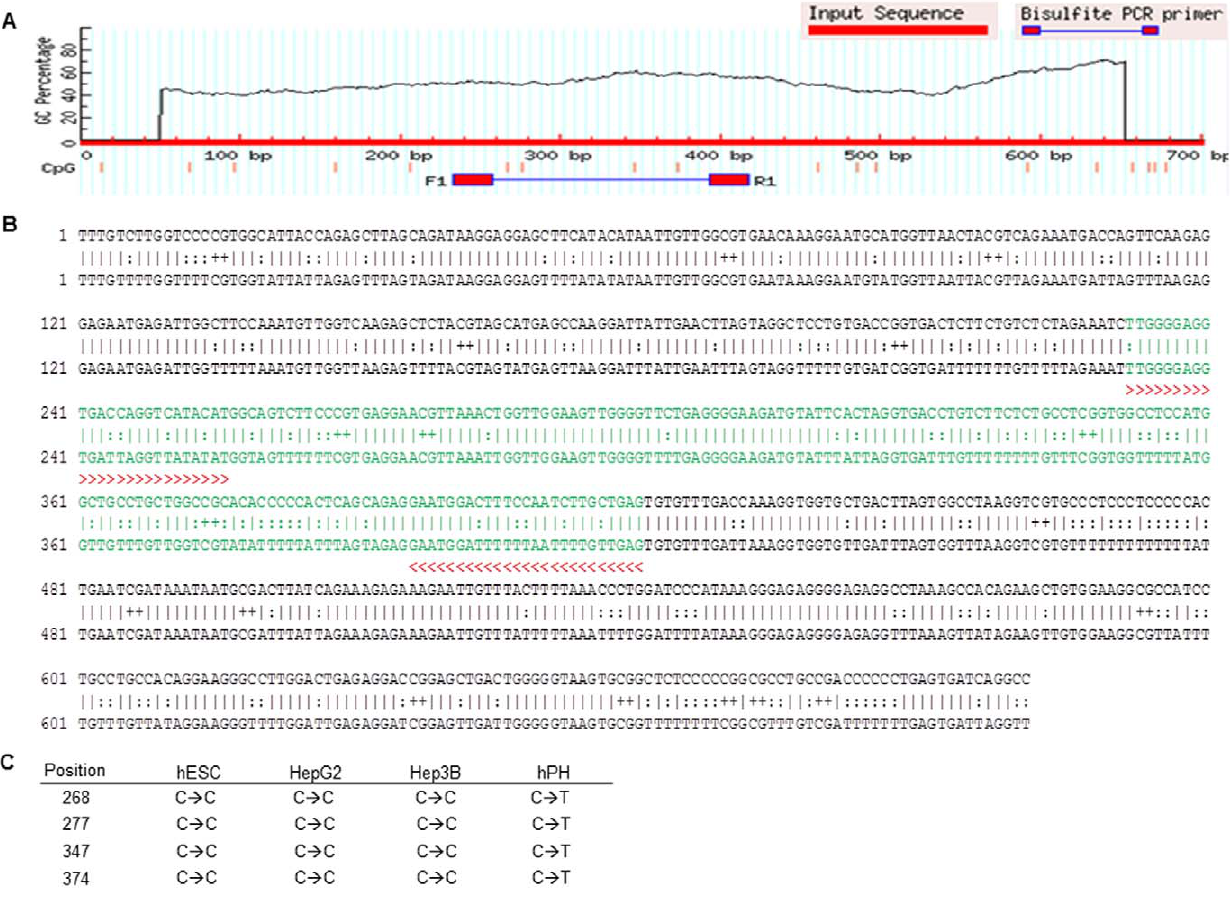
Figure 7. Bisulfite sequencing analysis of the predicted promoter region of miR-122 in hESCs, HCCs and hPHs. (A) Bisulfite sequencing PCR primer designed by the program MethPrimer using the predicted miR-122 promoter region as a template. (B) DNA sequence of the predicted promoter region of miR-122 entered into the MethPrimer program. The output shows the primers used to amplify the template with red colored arrows, the region amplified in green color, and the the cytocine (C) residue that would be converted into uracil if unmethylated is indicated with + . (C) The table shows the position of the cytocine from (B) that would be converted into uracil in absence of methylation in the bisulfite treated samples. Among the four cytocine positions, the bisulfite sequencing analysis showed that only the residues in hPHs were converted into uracil.